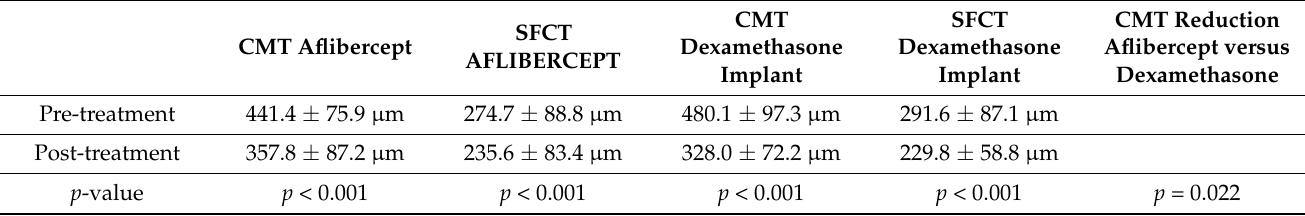
Table 1. Results of treatment with aflibercept and dexamethasone implants. CMT Reduction SFCT CMT SFCT Aflibercept versus Dexamethasone Dexamethasone CMT Aflibercept AFLIBERCEPT Dexamethasone Implant Implant Pre-treatment 441.4 ± 75.9 µ m 274.7 ± 88.8 µ m 480.1 ± 97.3 µ m 291.6 ± 87.1 µ m Post-treatment 357.8 ± 87.2 µ m 235.6 ± 83.4 µ m 328.0 ± 72.2 µ m 229.8 ± 58.8 µ